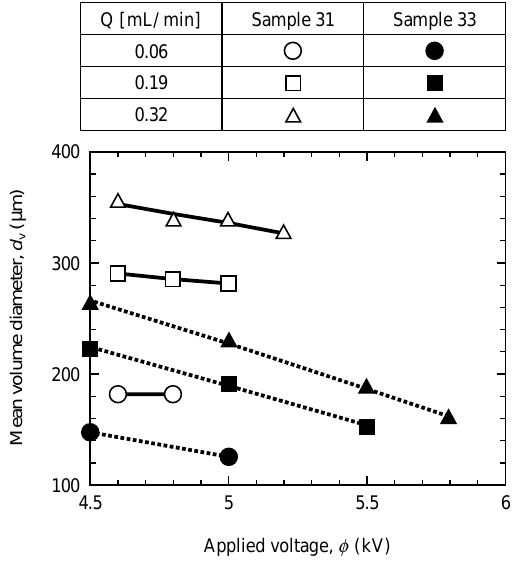
Particle Size Distributions in Uniform Cone-jet Mode Applied Voltage was 5